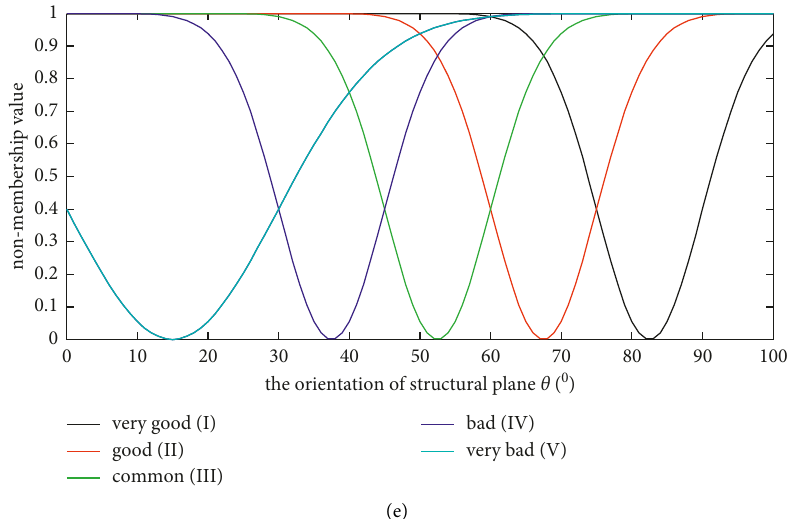
Figure 4: The non-membership degree function of surrounding rock quality. (a) The uniaxial compression strength of rocks at the saturation states ( R c ). (b) The rock quality index (RQD). (c) The water seepage of groundwater ( Q ). (d) The acoustic velocity of rock mass V . (e) The orientation of structural plane θ